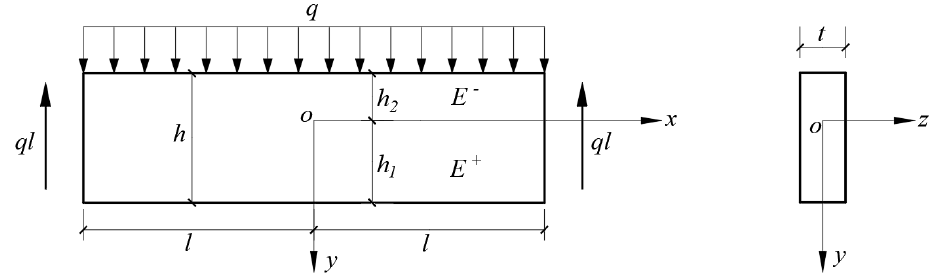
Figure 3. A bimodular beam under uniformly distributed loads in a thermal environment.